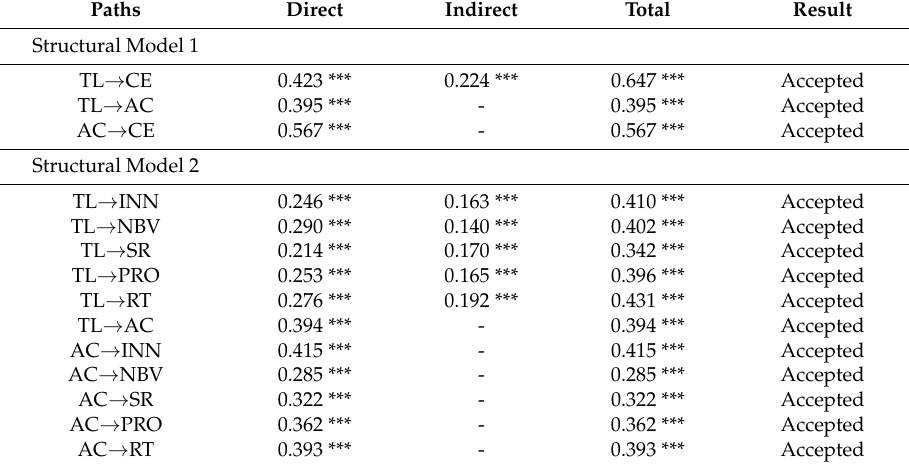
Table 4. Standardized